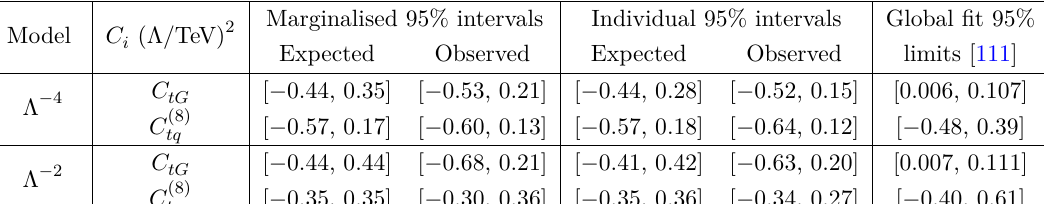
). The marginalised i